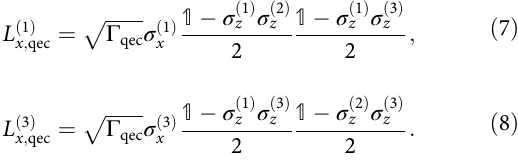
Fig. 2 Setup for the implementation of the error correction scheme. The setup consists of three system ions, which couple collectively to two shared motional modes a and b, used for the interrogation of the system. For the correction, we require auxiliary modes c ( j ) , which can be realized either by additional motional modes or ancilla ions. In the fi gure this additional degree of freedom is denoted by a level 1 j i levels, | 0 〉 and | 1 〉 , which we shall refer to as ground states, and two levels, | e 〉 and | f 〉 , referred to as excited states. The transitions are excited by a driving (weak carrier) fi eld Ω and strongly coupled to two motional sidebands a and b with coupling constant G . Excitations of the ions ( | e 〉 , | f 〉 ) are coherently transferred to the auxiliary modes/ancillas by coherent couplings g and subsequently removed by cooling/reset with a rate